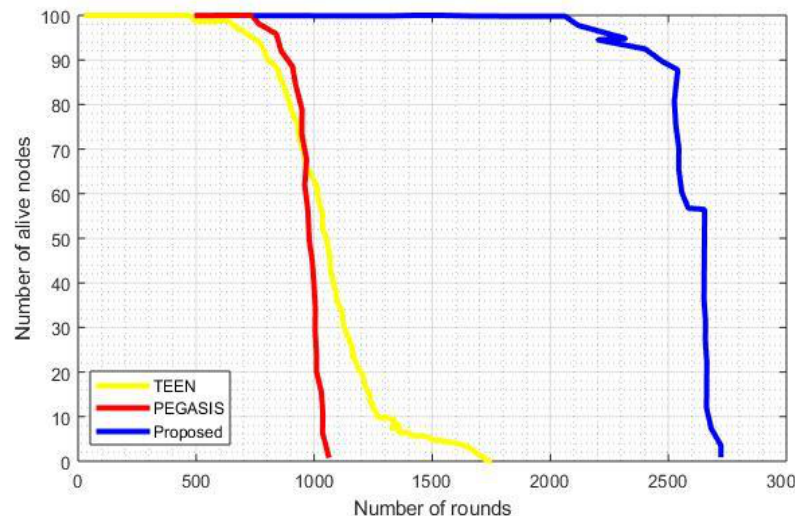
Figure 4. Number of rounds vs. number of alive nodes (100 nodes).